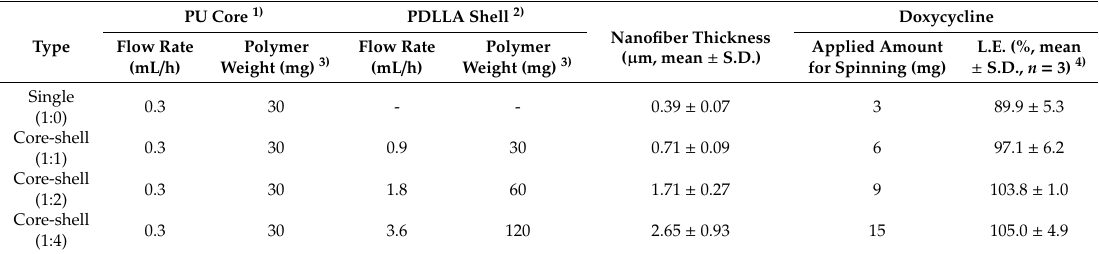
Table 1. Electrospinning condition and composition of single and core-shell